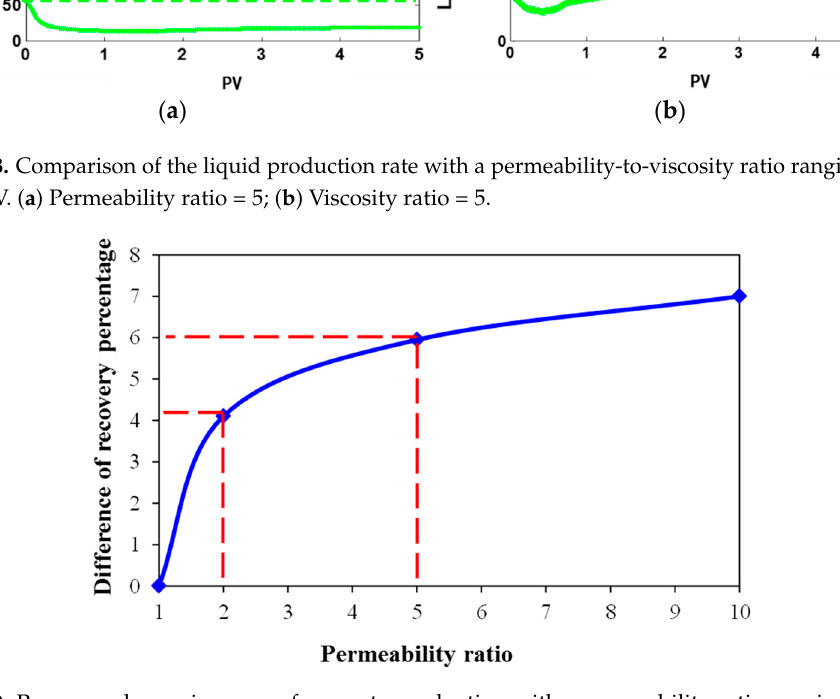
Figure 9. Recovery degree increase of separate production with a permeability ratio ranging from 1 to 10.